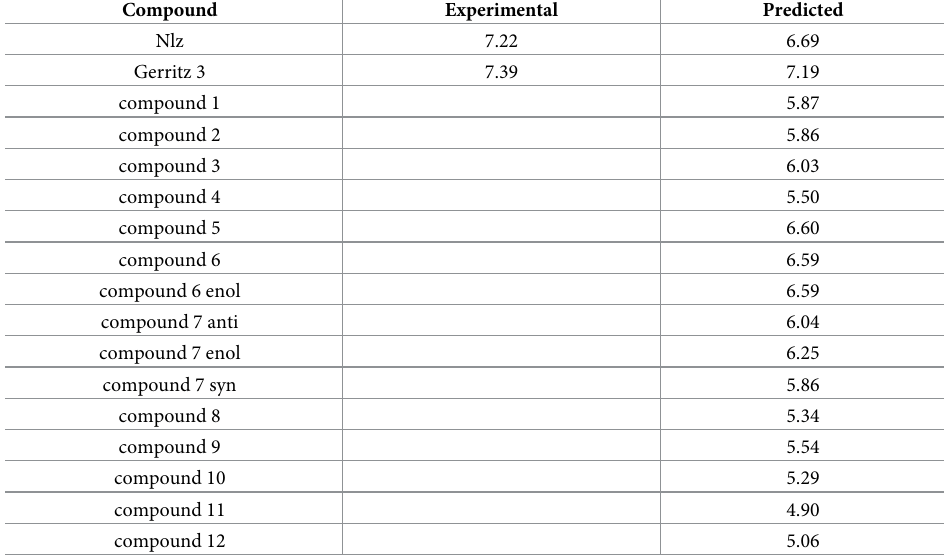
Table 4. Predicted activity for nucleozin